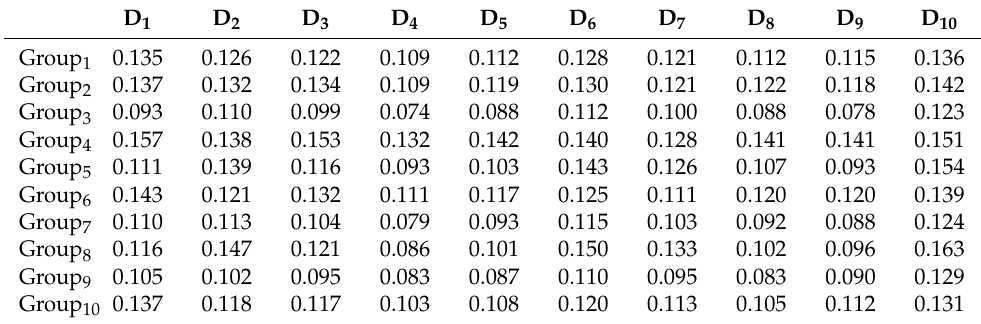
Table 8. Aggregated distances with